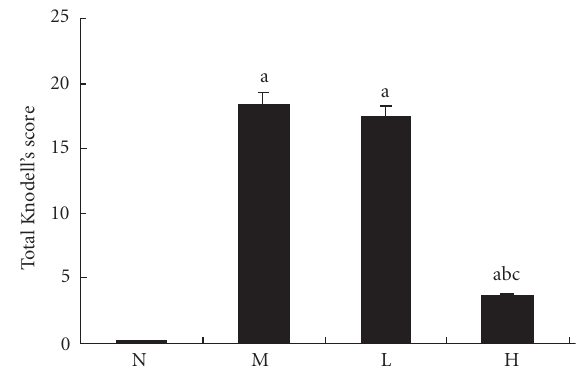
Figure 4: Comparison of total Knodell score of liver. N represented the normal control group; M represented the model group; L rep- resented the group treated with low dose of thalidomide; H repre- sented the group treated with high dose of thalidomide. a P < . 01 versus normal control group; b P < . 01 versus model group; c P < . 01 group treated with high dose of thalidomide versus group treated with low dose of